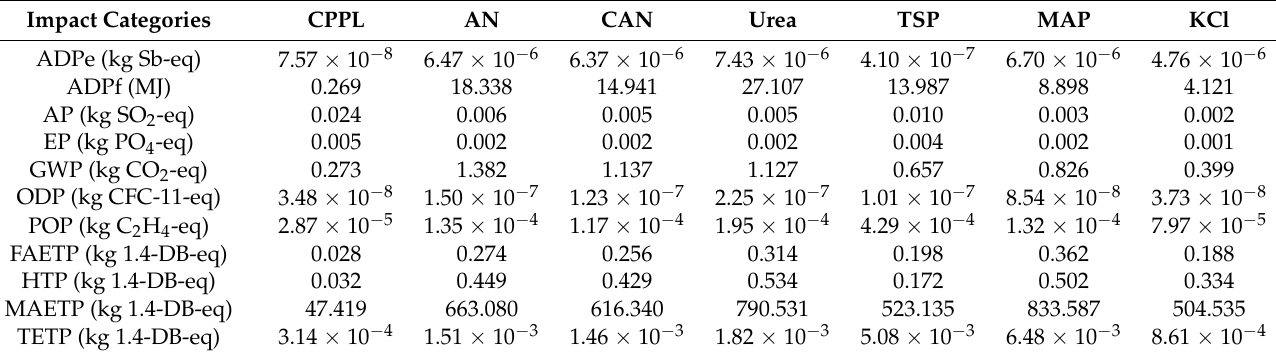
Table 7. Impact assessment of the production of 1 kg of CPPL and